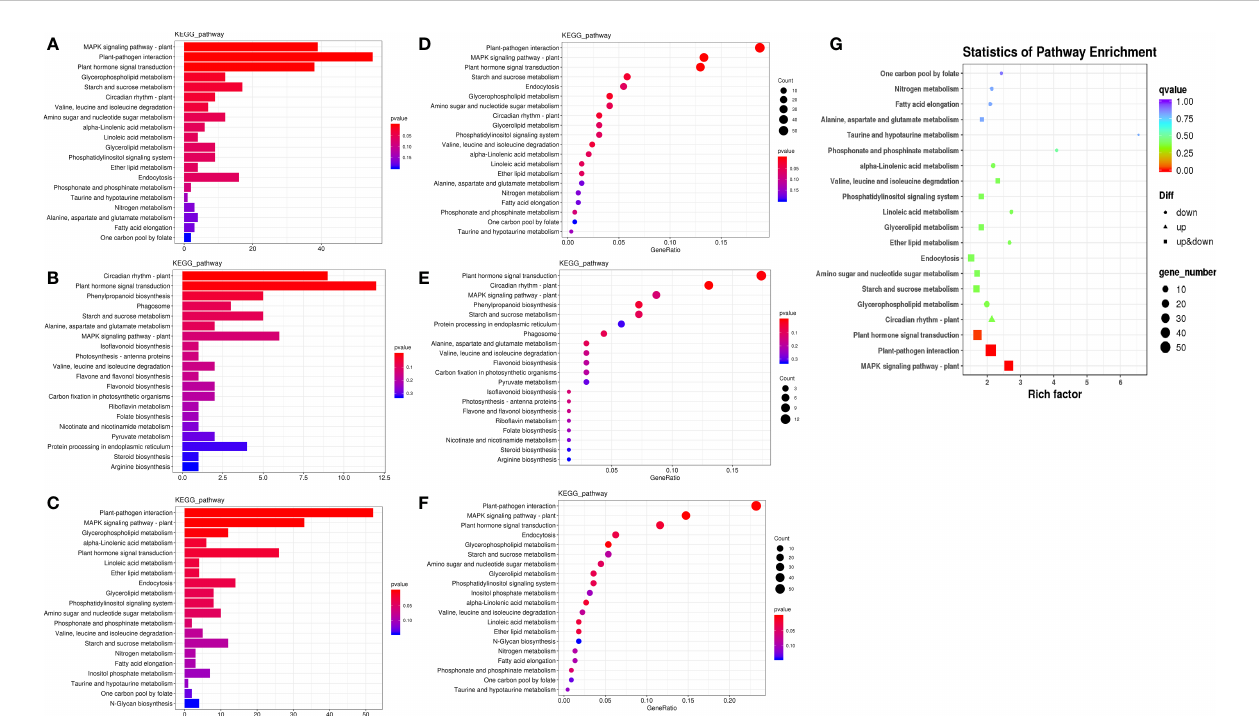
FIGURE 4 KEGG pathway enrichment of DEGs in K 0 vs. K ck . (A) Top 20 KEGG pathways enriched in DEGs in K 0 vs. K ck . (B) Top 20 KEGG pathways enriched in up- regulated DEGs in K 0 vs. K ck. (C) Top 20 KEGG pathways enriched in down-regulated DEGs in K 0 vs. K ck . The X-axis (GeneNum) represents the number of genes of interest annotated in the entry, the Y-axis indicates each pathway entry. The color of the column represents the P -value of the hypergeometric test. (D) Top 20 KEGG pathway enrichment bubble chart of all DEGs in K 0 vs. K ck . (E) Bubble chart of the top 20 KEGG pathways enriched up-regulated DEGs in K 0 vs. K ck . (F) Bubble chart of the top 20 KEGG pathways enriched in down-regulated DEGs in K 0 vs. K ck . The X-axis (GeneRatio) represents the proportion of the gene of interest annotated in the entry to the number of all DEGs, the Y-axis indicates each pathway entry. Dot size represents the number of DEGs annotated in the pathway, and dot color represents the P -value of the hypergeometric test. (G) Scatter plot of top 20 KEGG pathway enrichment of all DEGs in K 0 vs. K ck . Each circle represents a KEGG pathway, the Y-axis indicates the name of the pathway, and the X-axis represents the enrichment factor, which is the ratio of DEGs annotated to a certain pathway to total genes annotated to the pathway. The color of the circle represents the q-value, which is the P -value after multiple hypothesis test